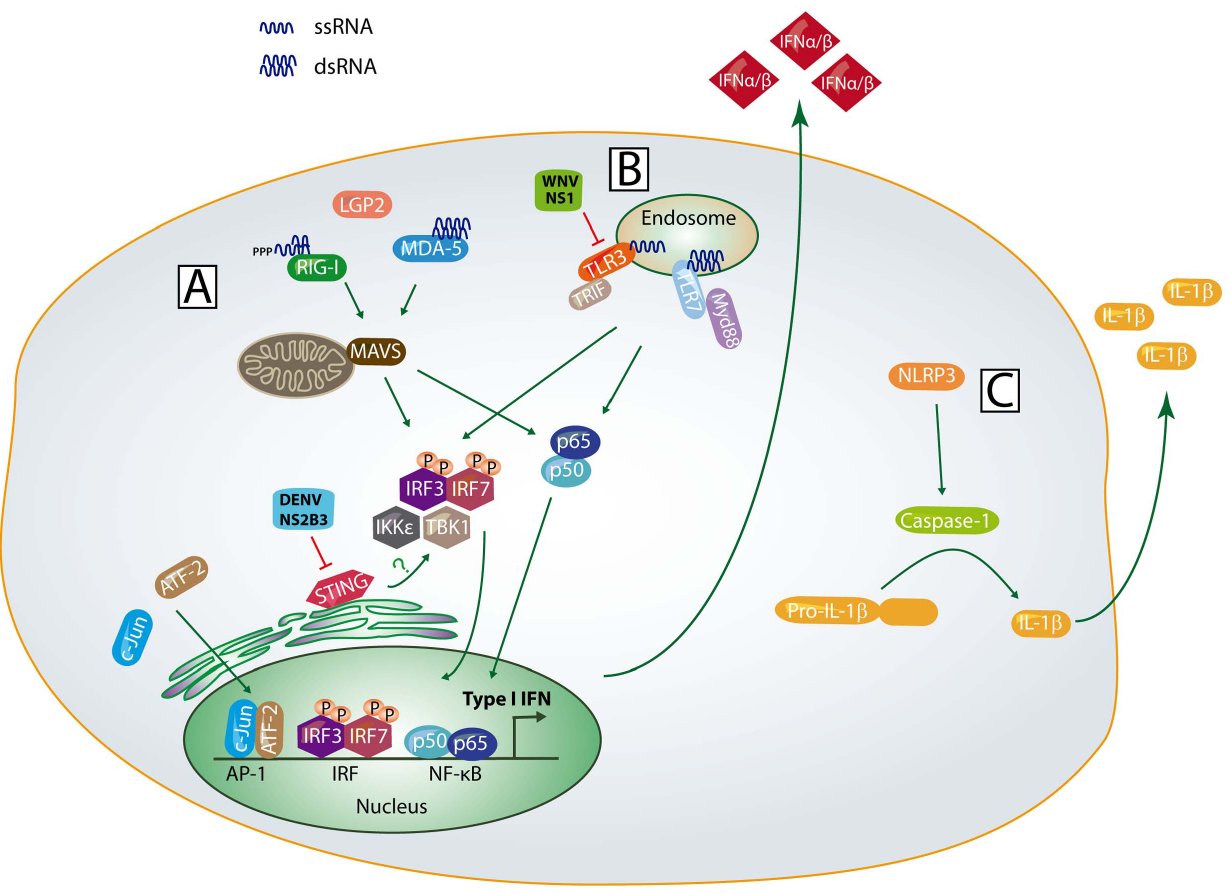
Figure 1. Innate immune sensing pathways. (A) Following non-self RNA binding, RIG-I and MDA5 undergo a conformational change, multimerize, and interact with MAVS through CARD-CARD interactions. This activates the adaptor STING and latent transcription factors IRF-3, IRF-7, and NF- k B to induce expression of IFN- b and IRF-3 target genes; (B) Within the endosomal compartment, TLR3 and TLR7 bind to non-self RNA, interact with their adaptor proteins, and activate IRF-3, IRF-7, and NF- k B dependent gene expression; (C) Upon detection of viral dsRNA or cellular stress signals, the NLPR3 oligomerizes, interacts with ASC, leading to activation of caspase-1 and IL-1 b processing. The signaling events and host factors targeted by WNV and DENV proteins are